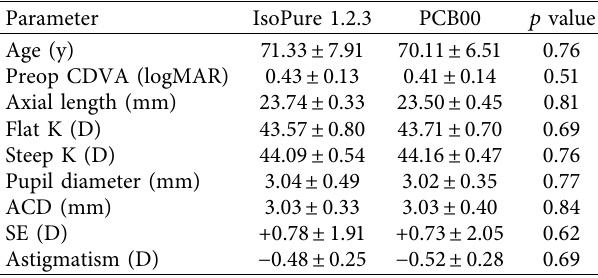
Table 1: Preoperative patient characteristics.